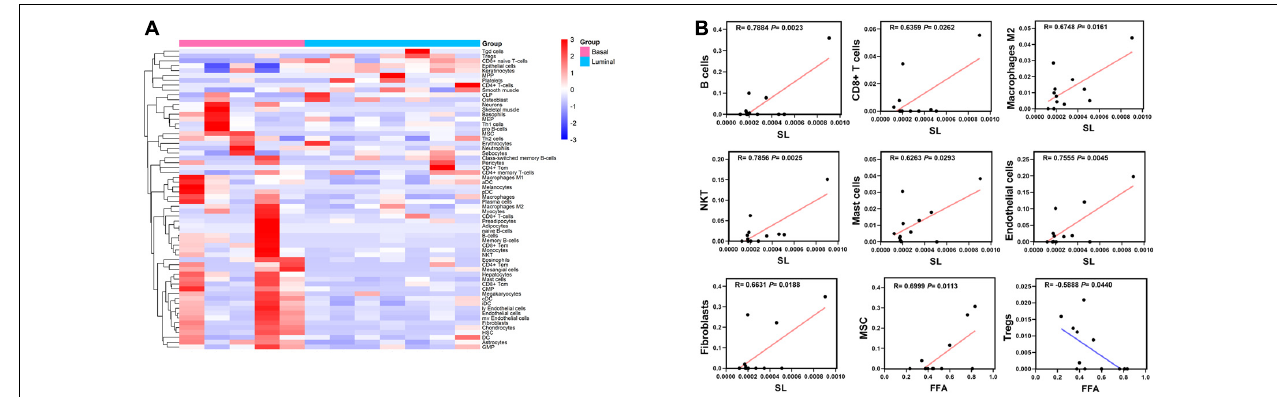
FIGURE 4 | Potential lipid biomarkers are associated with tumor microenvironment. (A) Heatmap of the relative frequency of immune cell and stromal cell types in basal and luminal MIBC samples as identified by the “xCell” algorithm. Red line represents the maximum expression level and blue line represents the minimum expression level. (B) Pearson correlation analysis revealed the relationship among FFA, SL, immune, and stromal cell types. Red line represents the maximum expression level and blue line represents the minimum expression level.